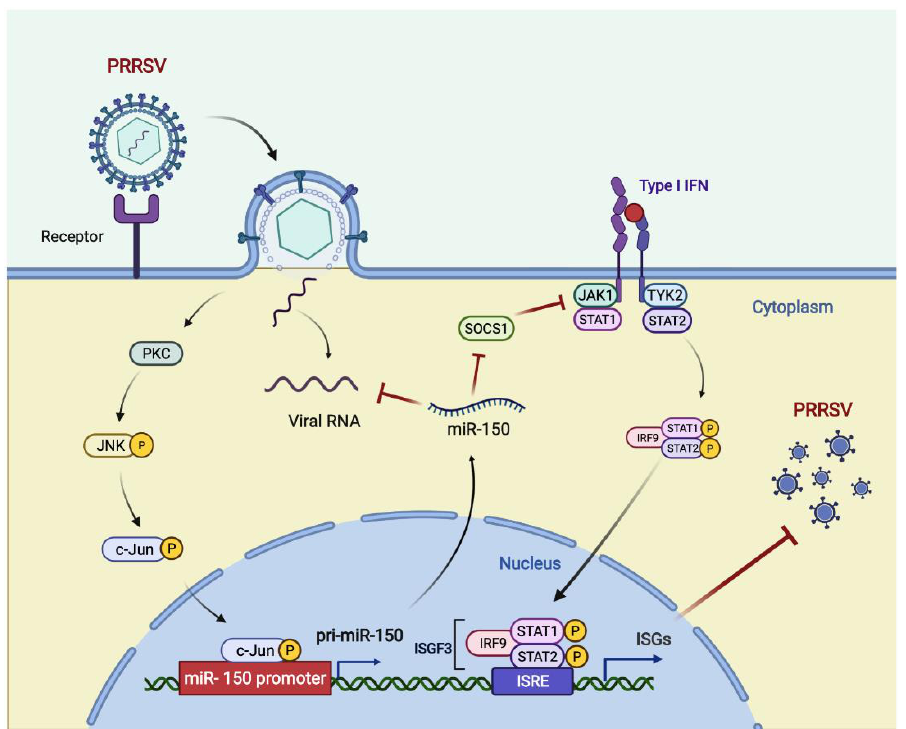
Figure 8. Model for the induced miR-150 to regulate PRRSV replication. Upon PRRSV infection, host cells upregulate c-Jun-mediated miR-150 expression as a host defensive strategy. miR-150 feedback suppresses PRRSV replication by targeting the viral genome. SOCS1-mediated suppression of ISGs is alleviated by miR-150; thus, suppressing PRRSV replication. Figure created